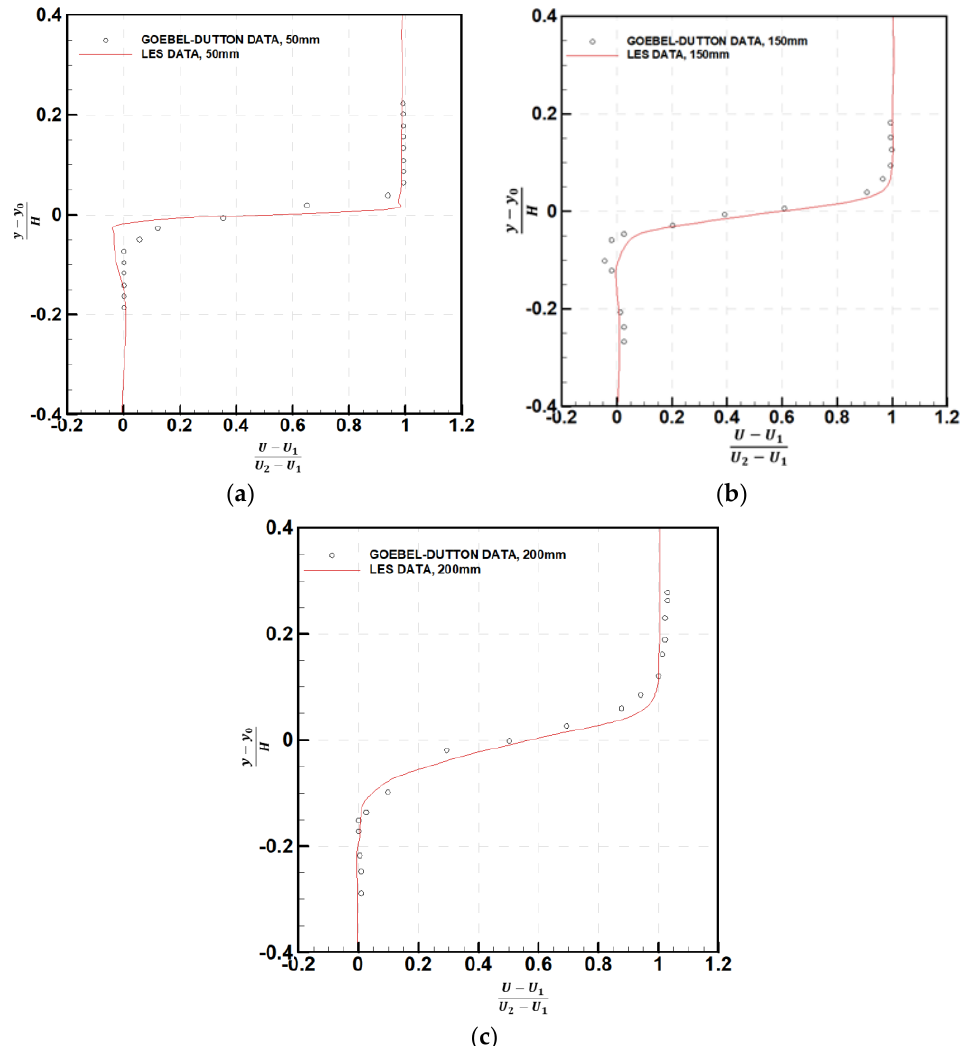
Figure 5. Comparison of time-averaged velocity profiles of mixing layers: ( a ) x = 50 mm; ( b ) x = 150 mm; ( c ) x = 200 mm.